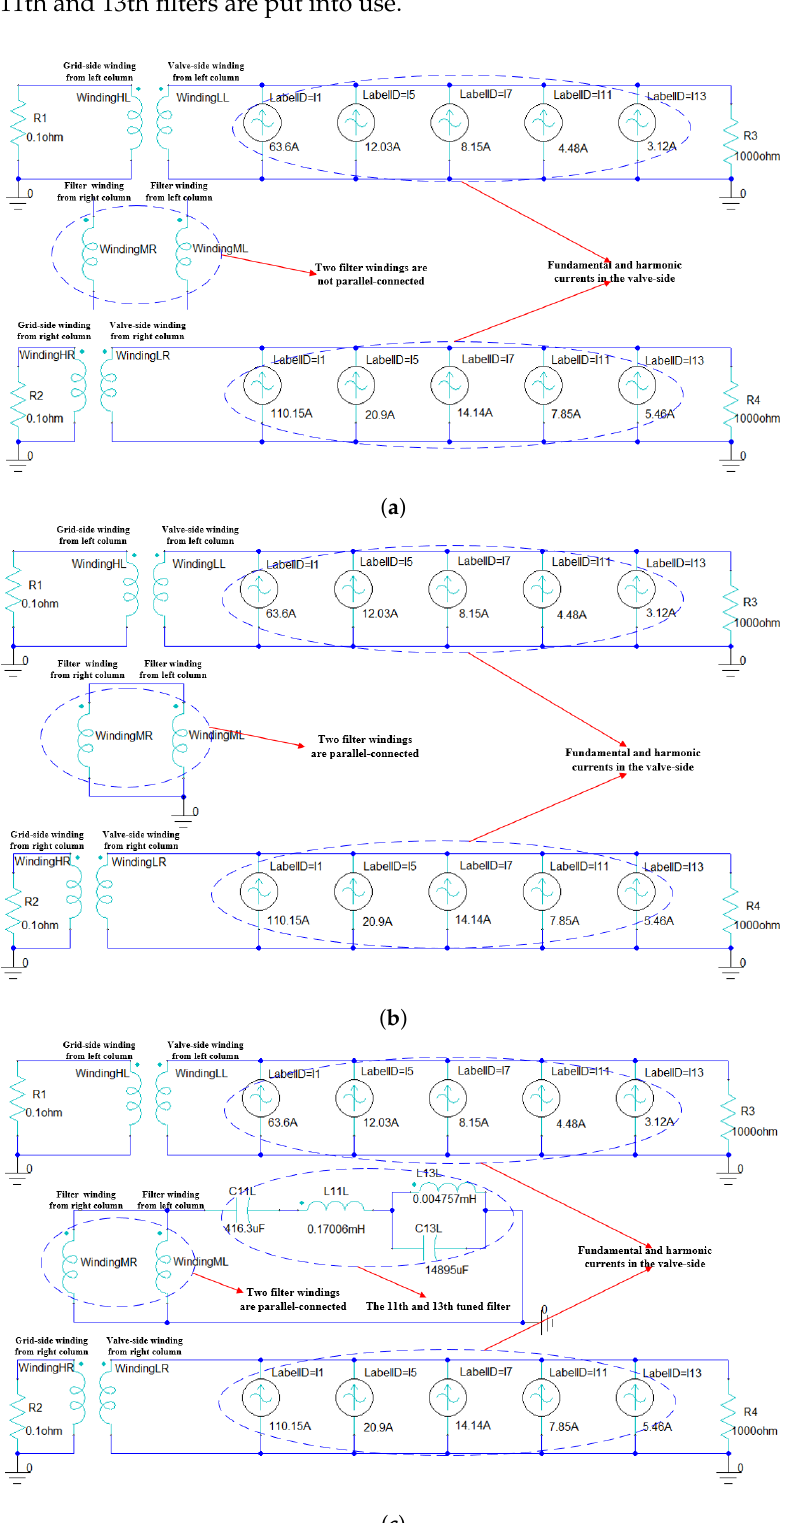
Figure 5. Field-circuit coupling models under three different working conditions. ( a ) Working condition 1. ( b ) Working condition 2. ( c ) Working condition